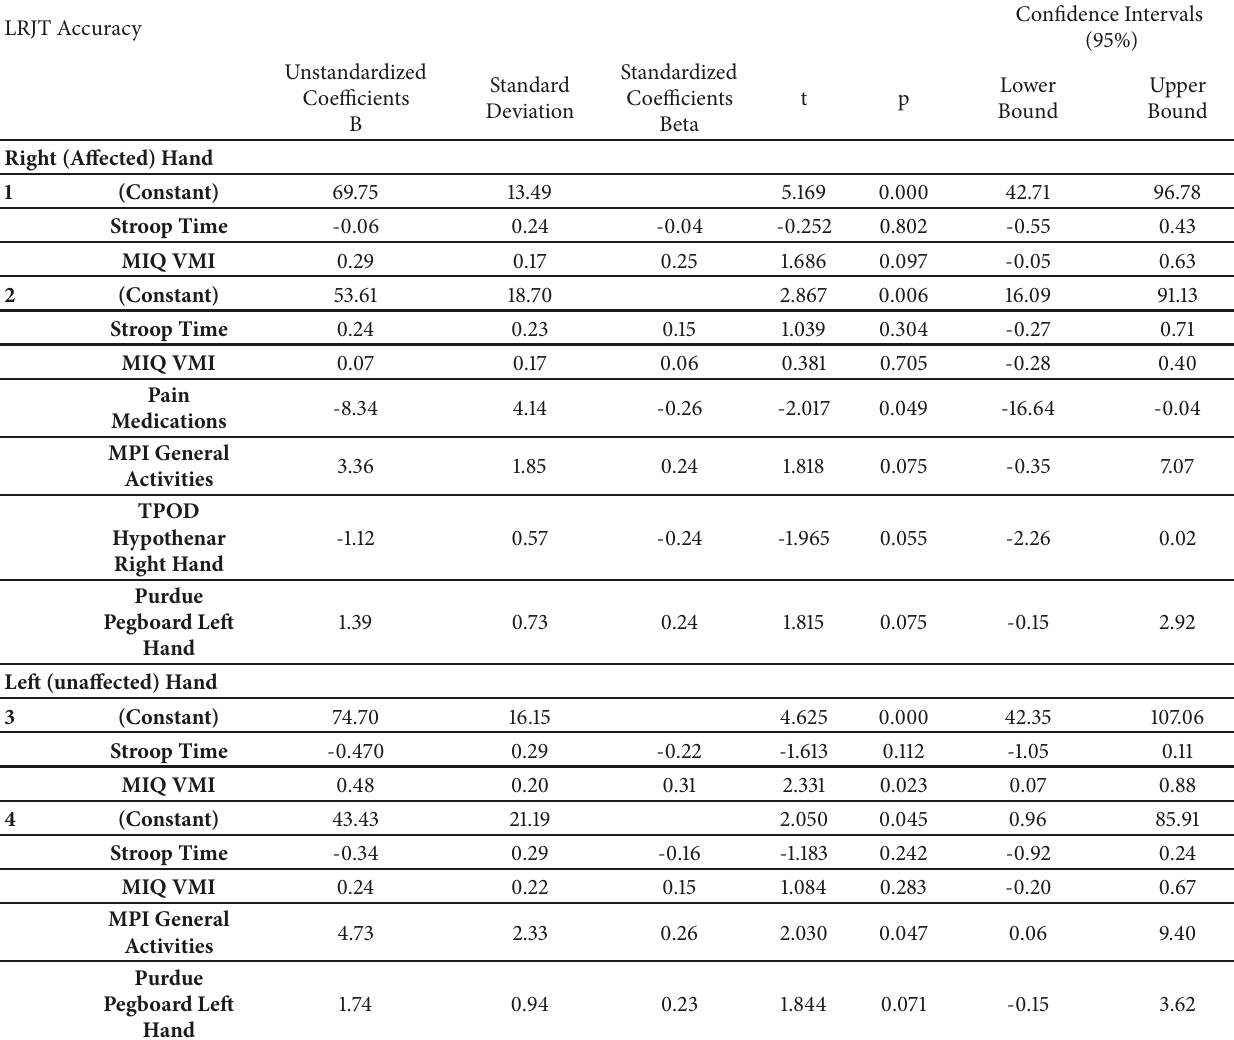
Table 3: Coefficients of best fitting MLR LRJT Right Hand Accuracy.